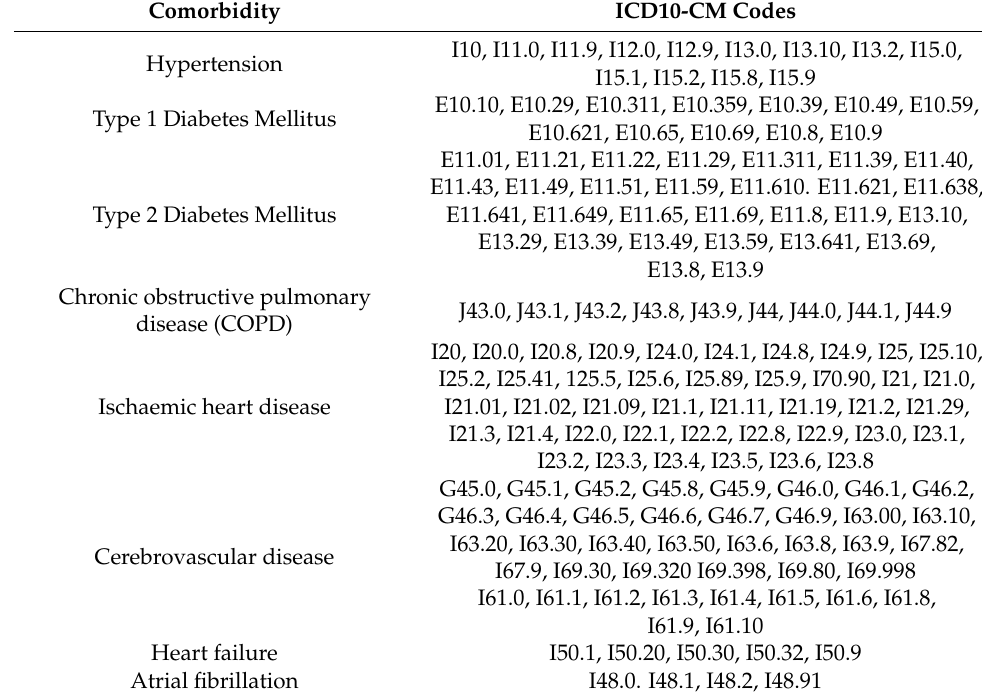
Table 1. Comorbidities of interest and related code